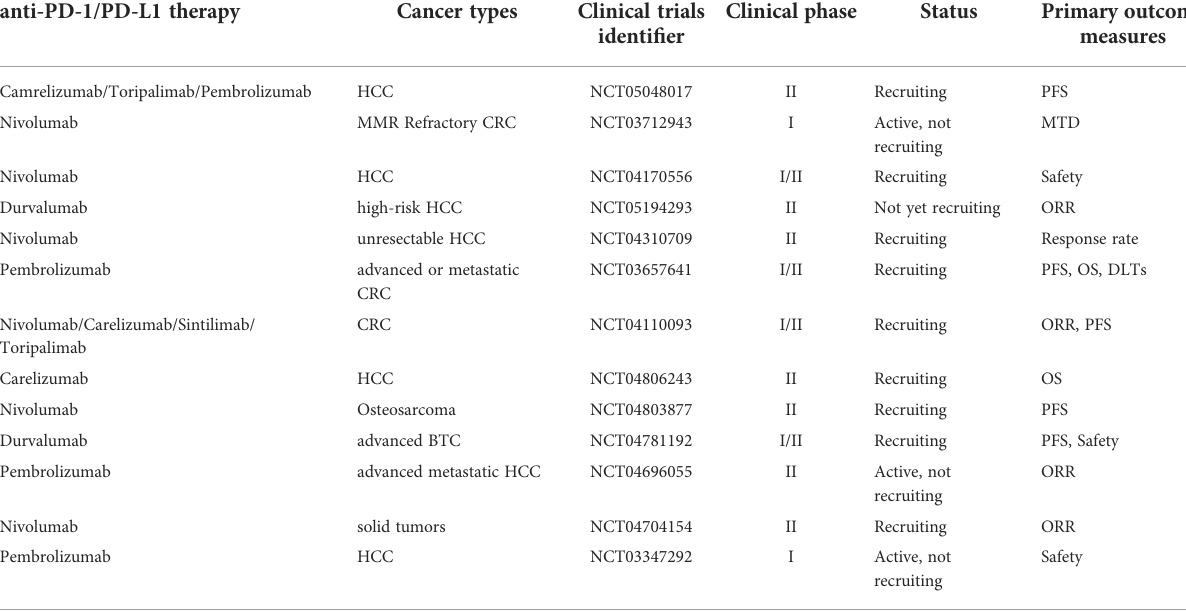
TABLE 2 Ongoing trials of regorafenib combined with anti-PD-1/PD-L1